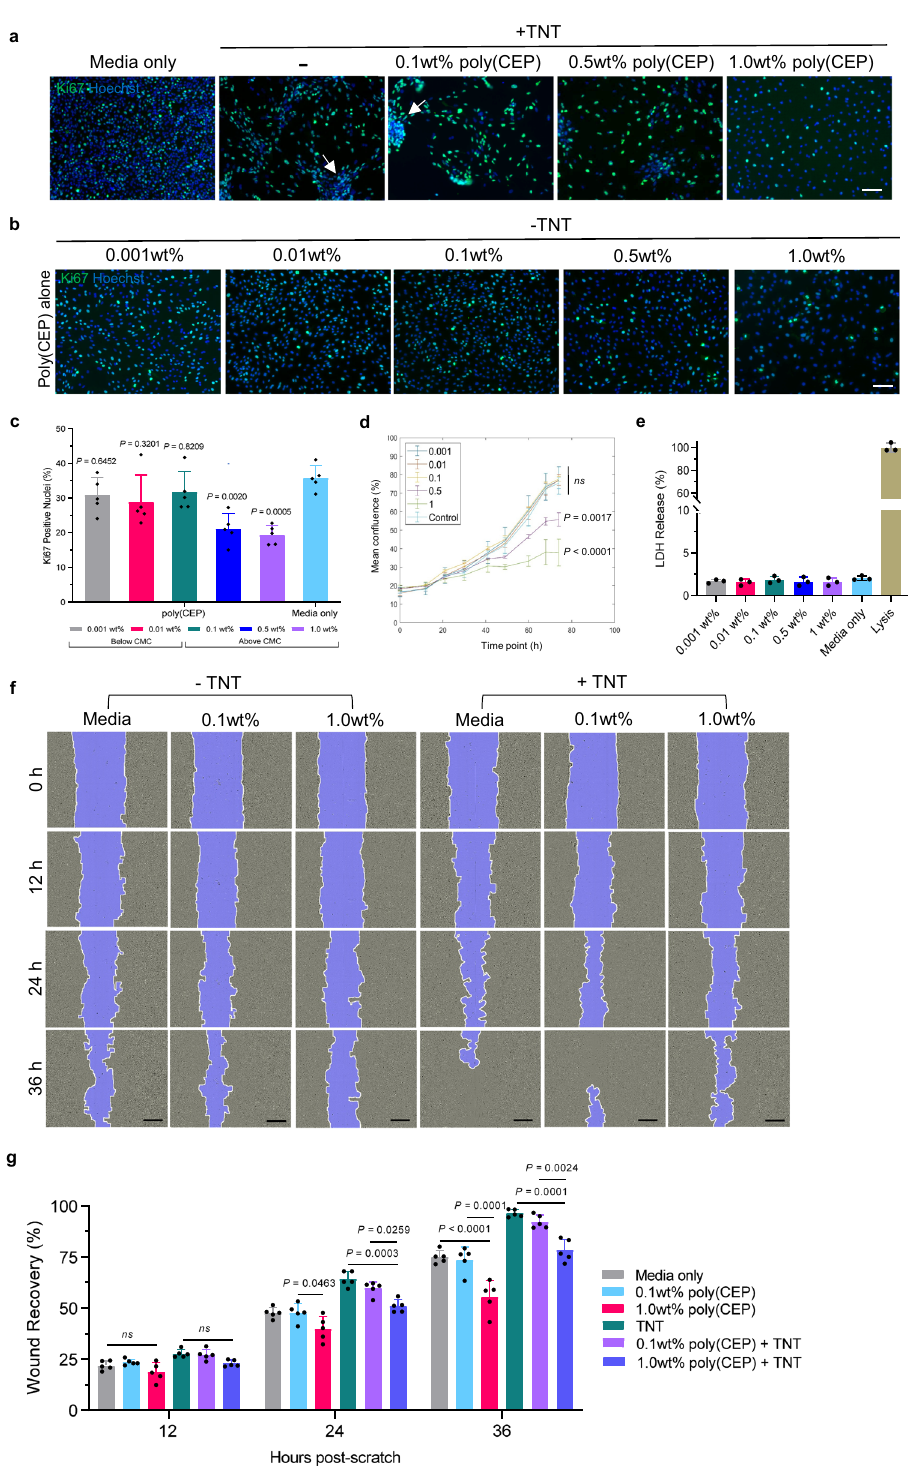
differentially expressed genes (DEGs) between the four conditions at both time points. Consistent with the PCA fi ndings, these comparisons revealed signi fi cant changes in the expression level of 3781 and 5162 genes in poly(CEP) + TNT compared to TNT, and 3472 genes and 6644 genes in poly(CEP) alone compared to media only control at 8 and 24 h, respectively (Supplementary Fig. 7c, d, and Supplementary Data 1 for full DE genes of both comparisons, + time points). 62% of DEGs (i.e 1484 out of 2380) in the poly(CEP) + TNT group were also upregulated in the